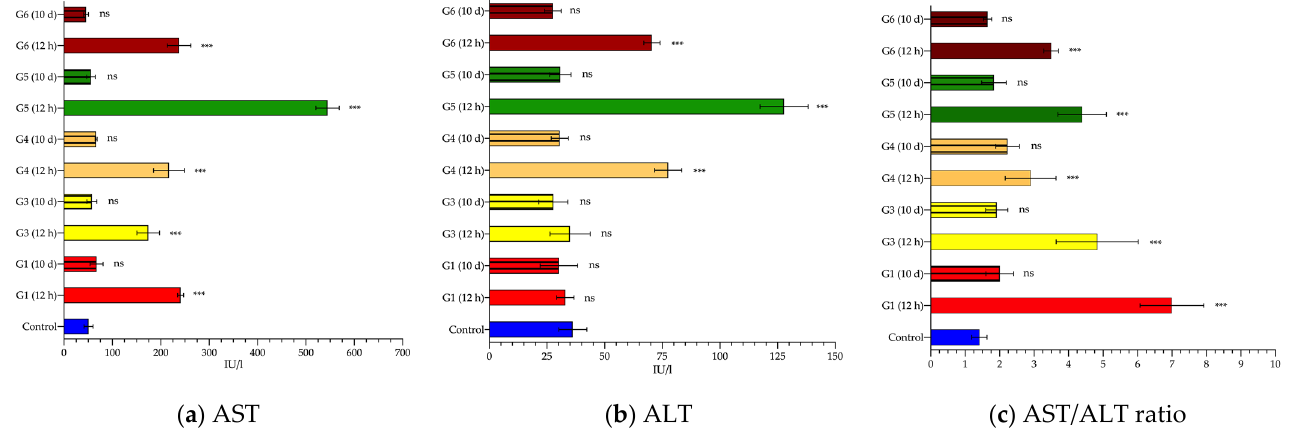
Figure 4. Serum values of liver enzymes. Aspartate transaminase (AST) ( a ), alanine transaminase (ALT) ( b ), and AST/ALT ratio (De Ritis ratio) ( c ) mean values (and standard deviation) measured in blood samples collected 12 h (smooth pattern) or 10 days (striped pattern) from control (blue), or alternating magnetic field (AMF)-exposed rats: 14 kA/m and 591 kHz (G1, red); 16 kA/m and 591 kHz (G3, yellow); 13.7 kA/m and 700 kHz (G4, orange); 14.4 kA/m and 774 kHz (G5, green); 11.2 kA/m and 856 kHz (G6, garnet). Values are expressed in international units per liter (IU/L). Statistical significance is shown compared to the control group values (***: p < 0.001; ns: p > 0.05).